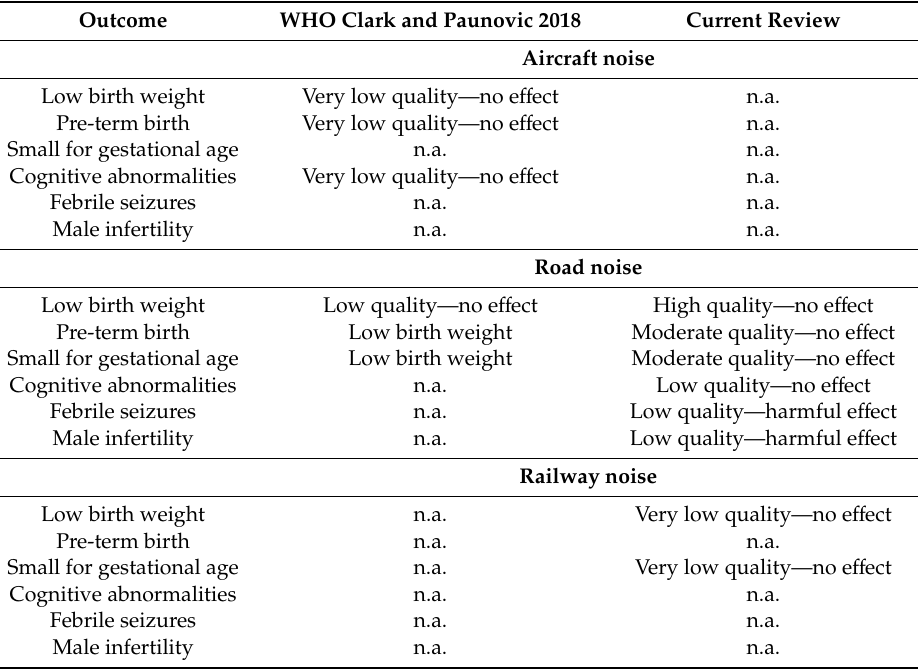
Table 13. Comparison of the strength of the evidence for the WHO 2018 and the current review for aircraft, road and railway noise, and birth and reproduction.